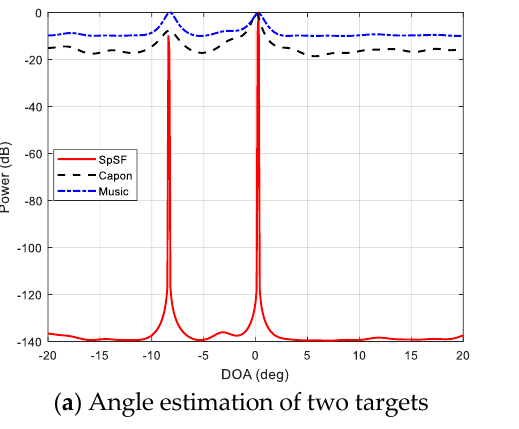
Figure 14. Estimation of two targets.